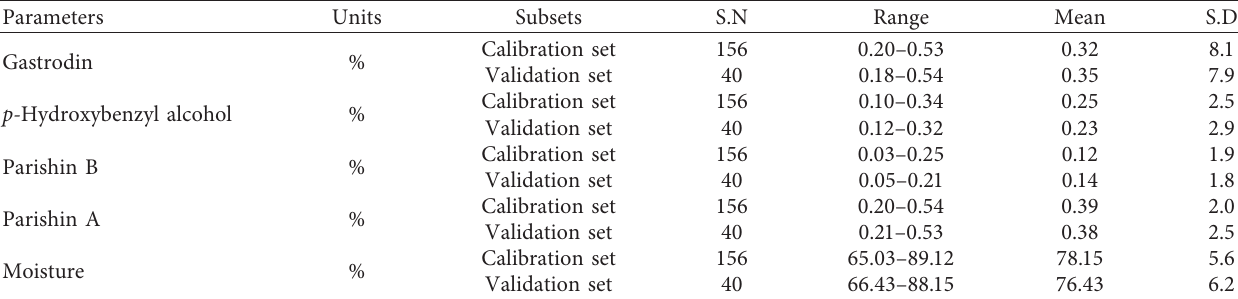
Table 3: Reference results of samples in calibration and validation sets.